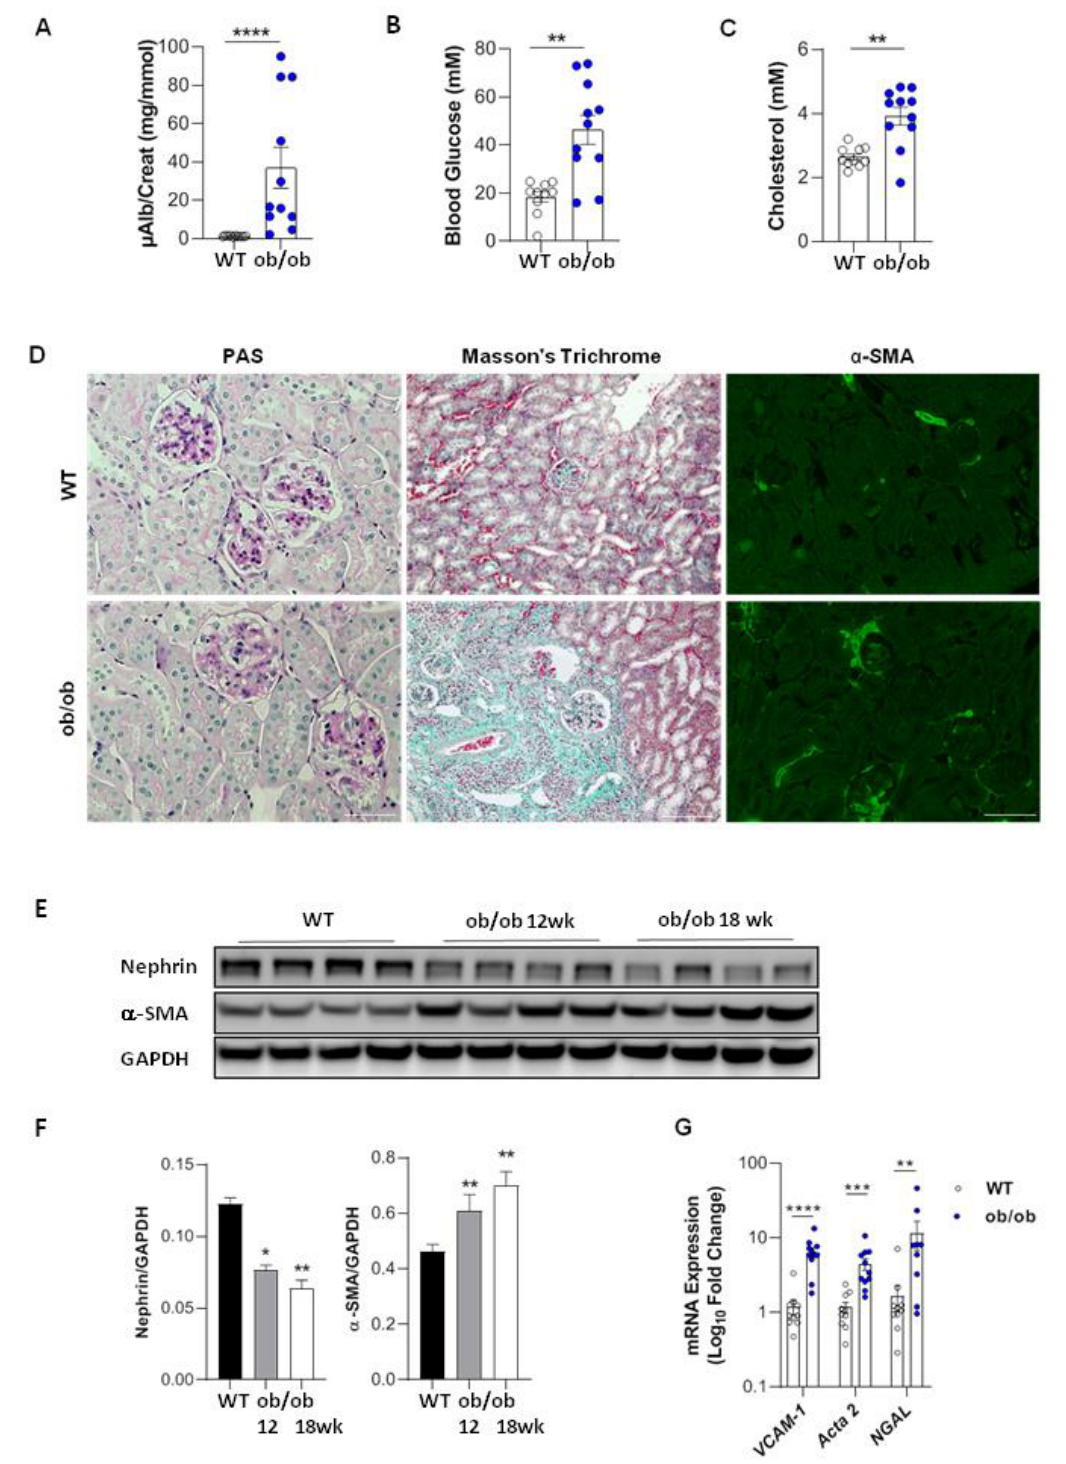
Figure 1. Renal function and structure in diabetic ob/ob mice. Microalbuminuria ( µ Alb)-creatinine ratio ( A ), blood glucose ( B ) and cholesterol ( C ), representative examples of Periodic Acid-Schiff (PAS), Masson’s trichrome coloration ( × 100), and α -SMA immunofluorescence staining ( × 200) ( D ), nephrin and α -SMA protein expressions by WB ( E , F ), and mRNA gene expressions of VCAM-1, Acta2, and N-GAL ( G ), in ob/ob mice. * p < 0.05, ** p < 0.01, *** p < 0.001, **** p < 0.0001 compared to WT controls. Bars = 50 µ M (right) and 100 µ M (middle, left). n = 10 WT mice vs. 11 ob/ob mice ( A – D , G ). In WB experiments, n = 4 mice per group, WT, and 12 weeks or 18 weeks old ob/ob mice ( E , F